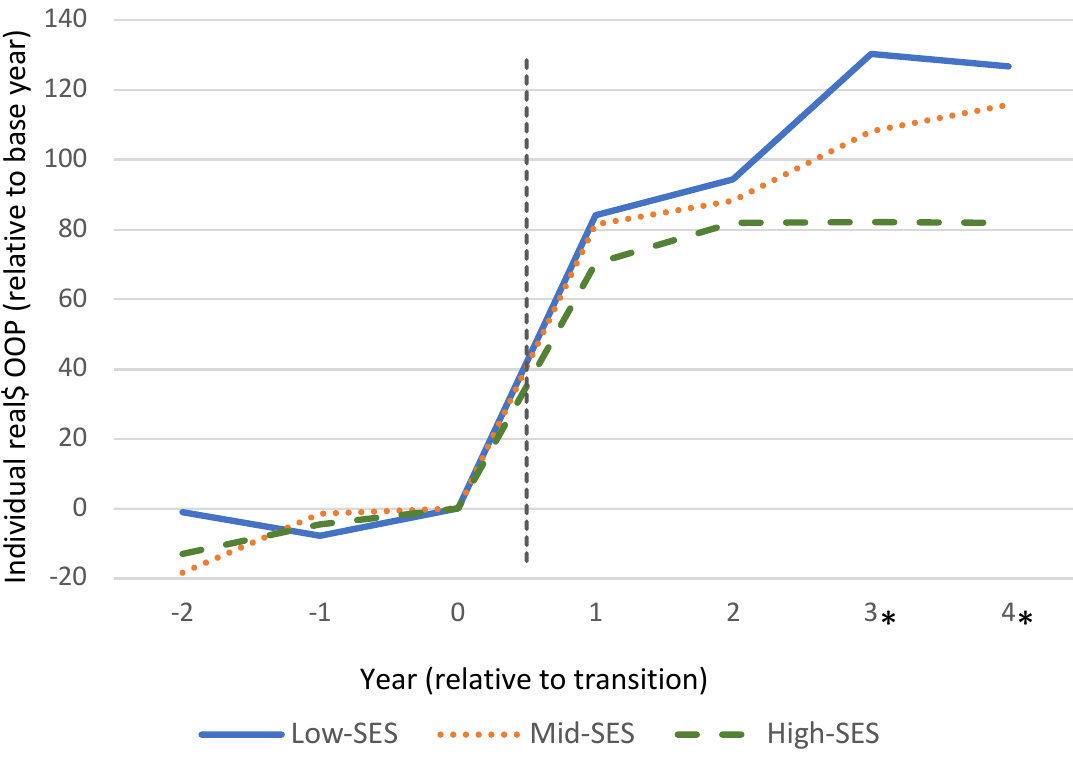
Figure 5: Estimated effects of choice devolution on mean annual OOP medical expenditure burdens among the least healthy (top ACG score quartile). Notes: This figure shows pooled difference-in-difference estimates of changes in OOP medical expenditures among enrollees at firms that transition to devolved choice of deductible level, with the sample restricted to persons in the top 25 percent of the ACG health risk score distribution at the pre-devolution baseline. SES categories correspond to the bottom 25 percent, middle 50 percent, and top 25 percent of the sample distribution. The model is estimated with year-fixed effects and with person-fixed effects centered at the pre-devolution level. ∗ indicates a statistically significant difference between the high- and low-SES groups at p <